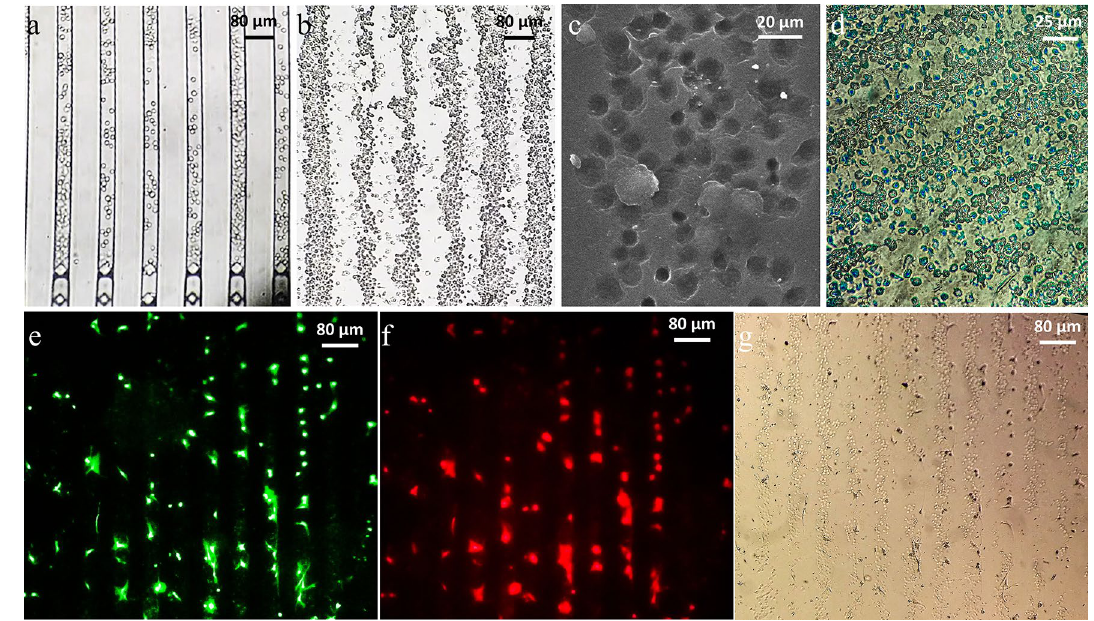
Figure 6. ( a ) The function of the microfluidic chip in trapping chondrocytes in an area around terminal microposts of 40 µm microchannels of the microfluidic chip, which is almost filled with chondrocytes. ( b ) The regular pattern of chondrocytes transferred to the cell-culture plate. ( c ) The chondrocyte-imprinted substrate SEM image was prepared by a microfluidic chip with 40 µm microchannels. ( d ) Stained ADSCs cultured in a 25 µm microfluidic chip on the cell-imprinted substrate with alcian blue. ( e ) Phalloidin staining of actins in cultured ADSCs in a microfluidic chip on the cell-imprinted substrate. ( f ) Immunostaining of ADSCs cultured in a microfluidic chip on the cell-imprinted substrate with fluorescent AlexaFluor488 labeled wheat germ agglutinin (WGA). ( g ) Optical microscopy of ADSCs cultured in a microfluidic chip on the cell-imprinted substrate.